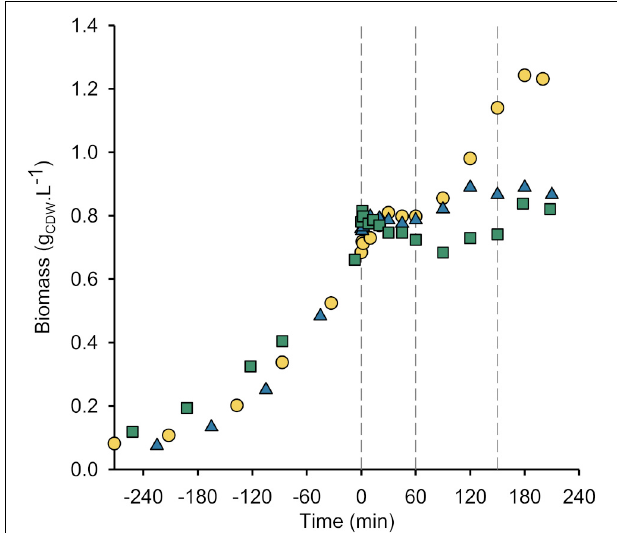
FIGURE 3 | Growth is inhibited by SHX, not (p)ppGpp. Growth curves of wild-type P. putida KT2440 (yellow circle), (cid:49) relA mutant (blue triangle) and ppGpp 0 strain (green square). The vertical dashes delimit the different growth phases defined for the WT strain (see Figure 1 ). The results obtained from the other biological replicates are shown in Supplementary Figure 4